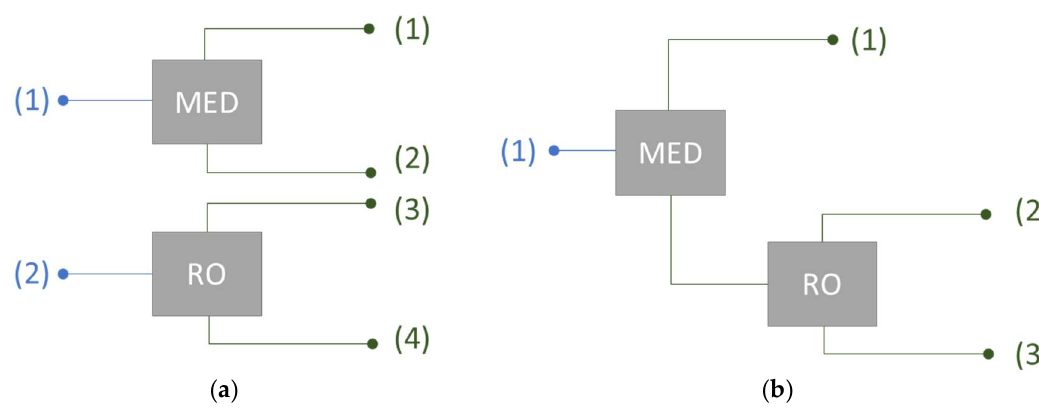
Figure 1. Example configurations for water desalination ( a ) with two inlet nodes and four outlet nodes, ( b ) with one inlet node and three outlet nodes.